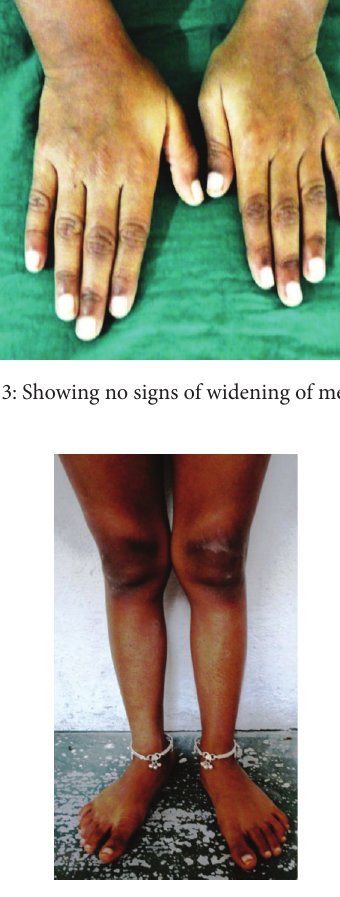
Figure 2: Showing no signs of rachitic rosary and Harrison’s groove.